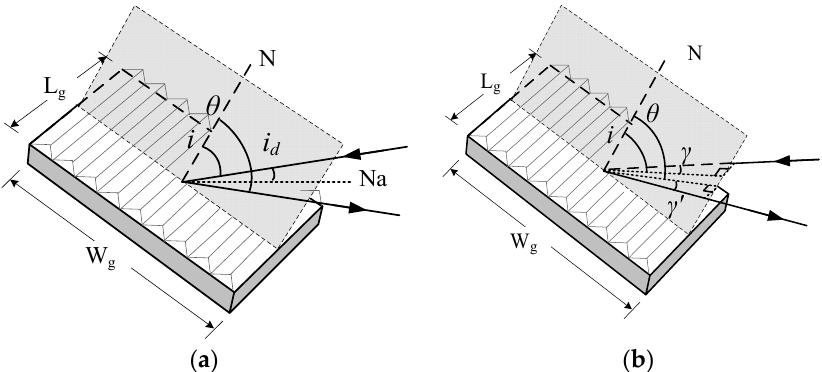
Figure 5. ( a ) In-plane Quasi-Littrow mode (IQLM); ( b ) Off-plane Quasi-Littrow mode (OQLM). The gray plane is the principal plane of the echelle, N is the normal of the echelle plane, and Na is the normal of the reflective facet. i and θ are the angles of incidence and diffraction, respectively. i d is the angle between the incident rays and Na. γ and γ ’ are the angles at which the incident and diffraction rays deviate from the principal plane, respectively. W g × L g is the size of the echelle.